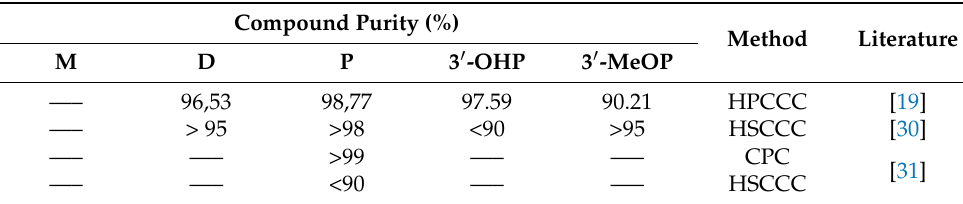
Table 2. The purity of polar kudzu root isoflavone isolates obtained in other studies realized using various counter-current preparative